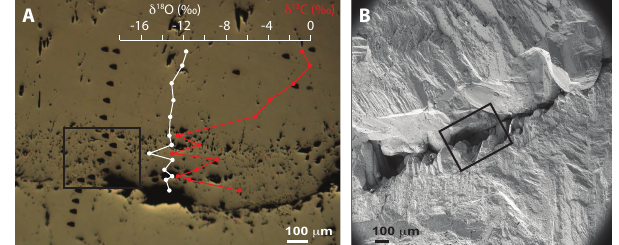
Figure 8, Pacton et al. Fig. 8. Microphotographs of segments of stalactite sample after ion- probing. δ 13 C measurements indicate more negative values in the cavities, as shown by the SEM picture.